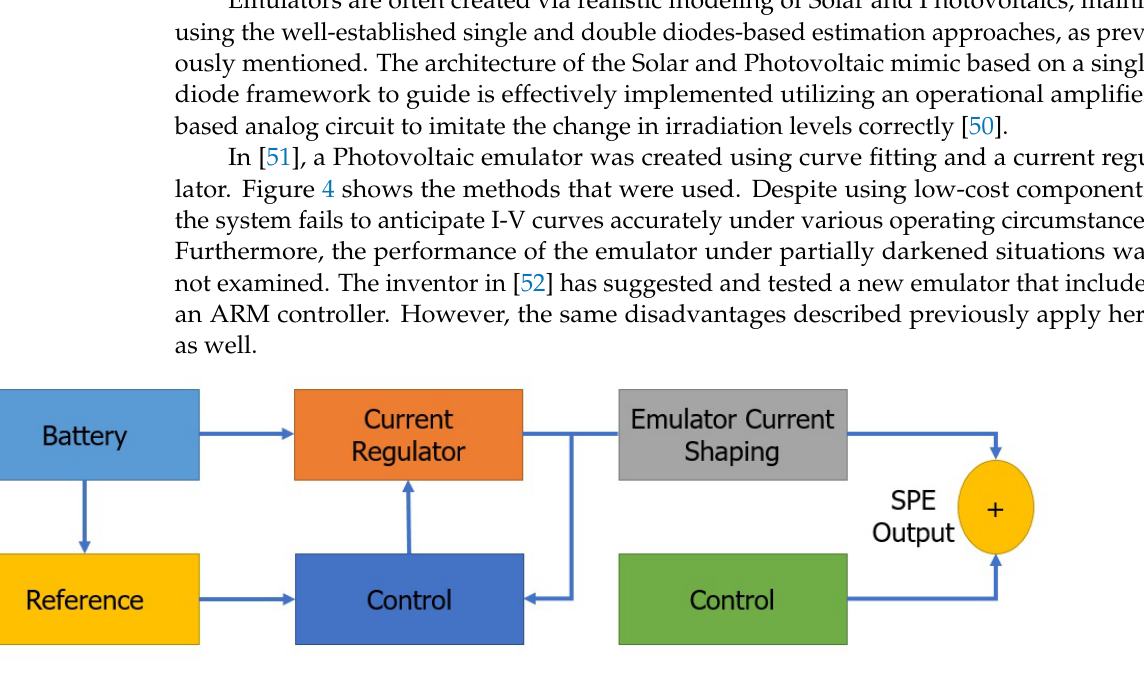
Figure 4. Solar and Photovoltaic emulator